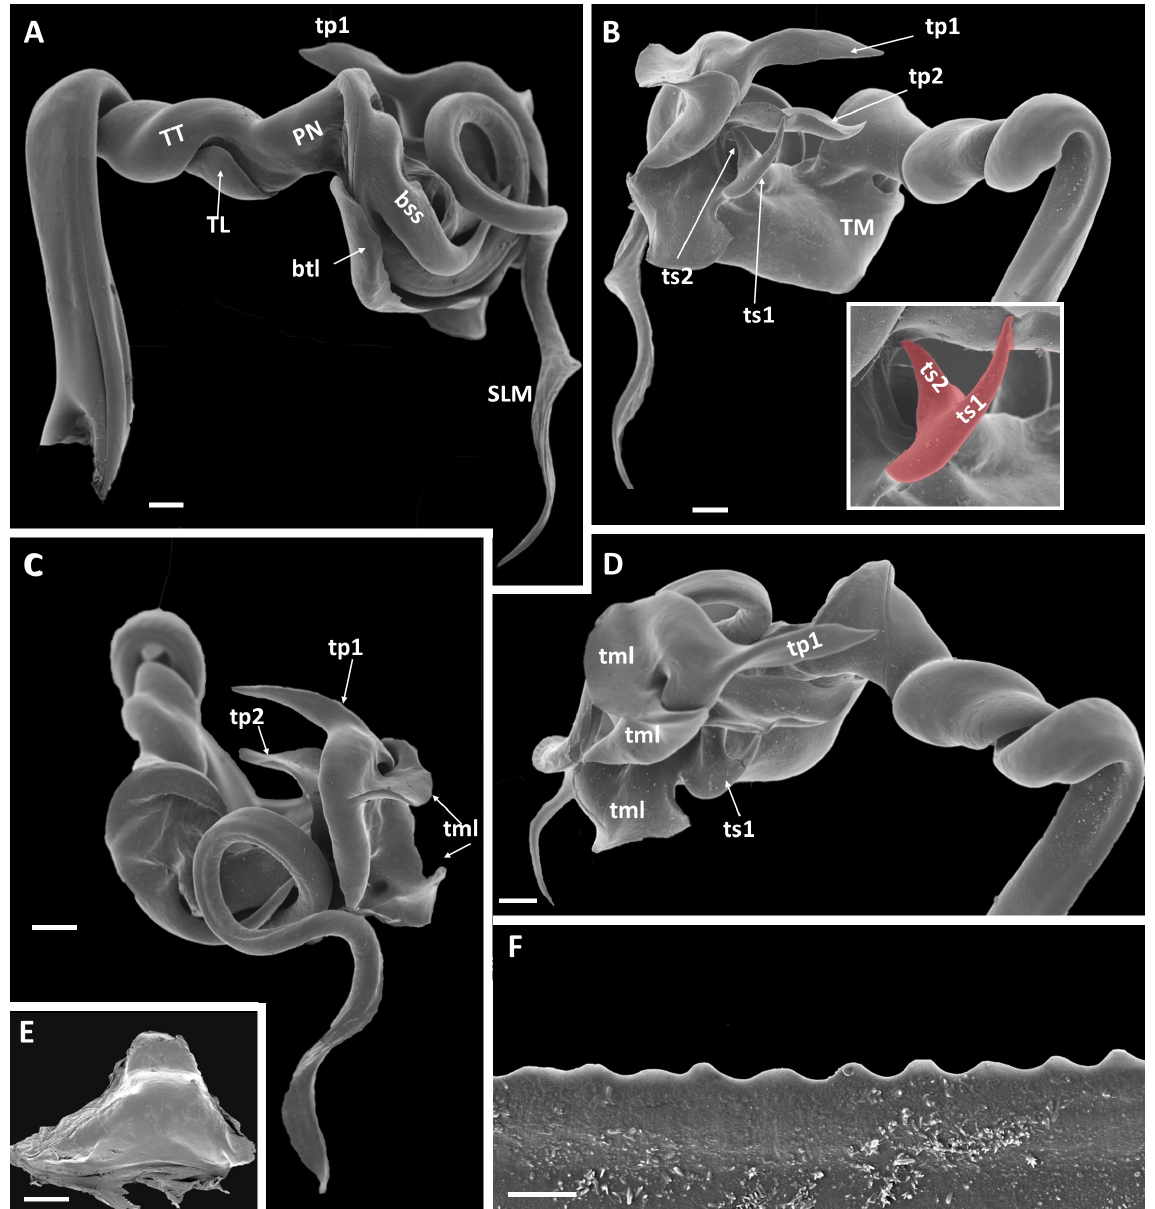
Fig. 25. Chaleponcus jolantae sp. nov., holotype, ♂ (NHMD 621723). A–D . Right gonopod telopodite. A. Posterior view. B. Anterior view (inset: telomeral spines enlarged and highlighted). C. Submesal view, basomere erased. D. Lateroanterior view. E . Sternum 9. F . Midbody dorsal limbus. Abbreviations: btl = basal telomeral lamella; PN = post-torsal narrowing; SLM = solenomere; TL = torsotope lobe; TM = telomere; tp1 , tp2 = telomeral processes; ts1 , ts2 = telomeral spines; TT = torsotope. Scale bars: A–D = 0.1 mm; E = 0.2 mm; F = 0.01